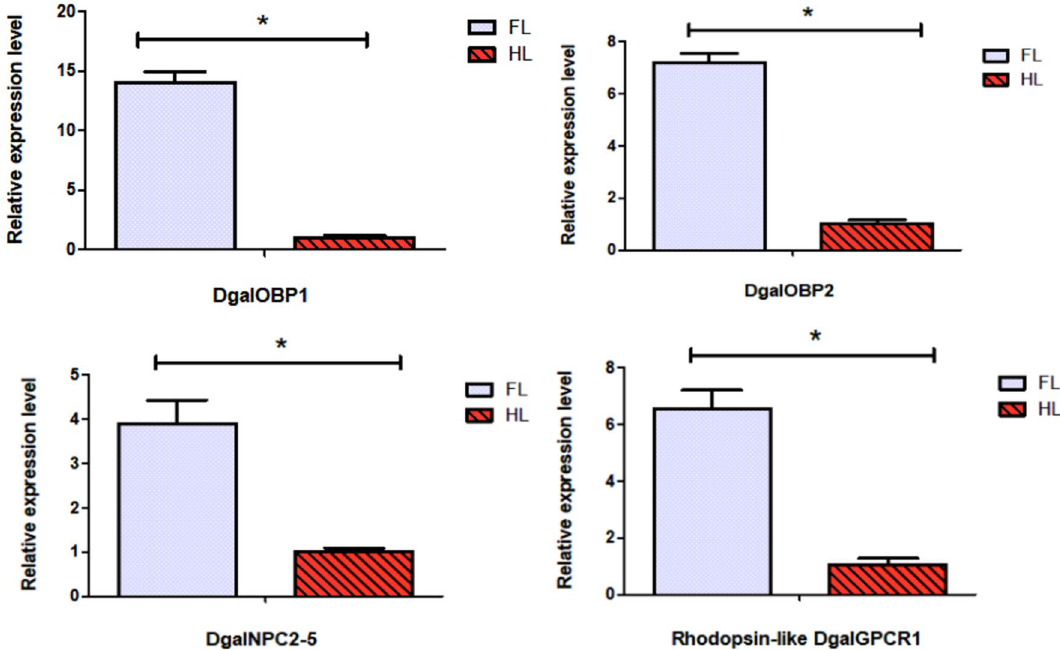
Figure 7. Expression profiles of putative chemosensory genes in D. gallinae using qRT-PCR. FL, forelegs; HL, hindlegs. Error bars represent means ± SEM, and asterisks above indicate significant differences between forelegs and hindlegs (* p <